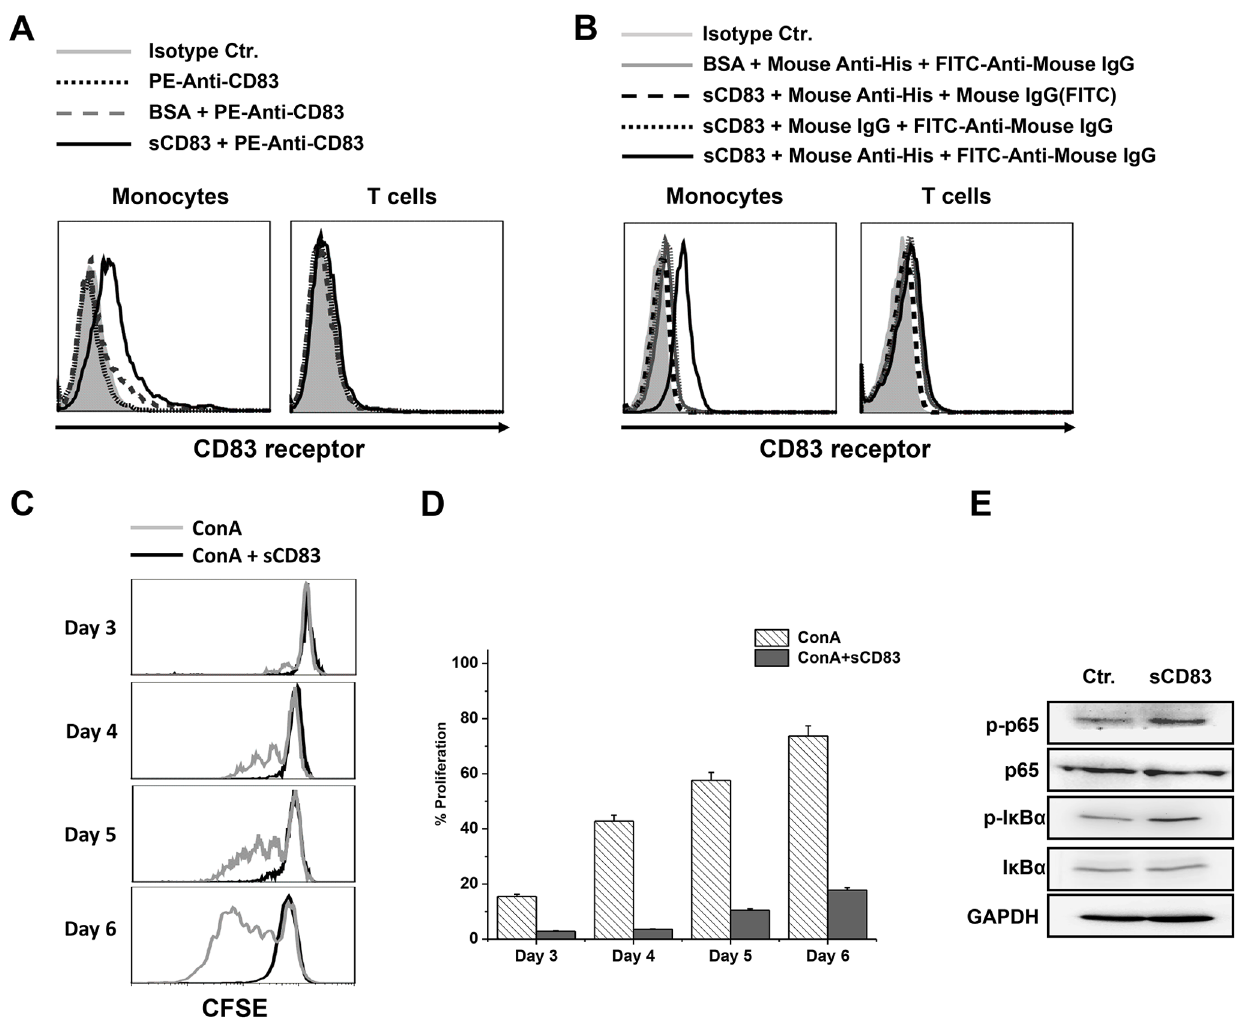
Figure 6. Biological activity determination of sCD83. sCD83 bound to the putative CD83 receptor on monocytes but not on T cells. (A and B) PBMC were incubated with soluble CD83 or BSA, and then coated with either PE-anti-CD83 (A) or anti-His followed by FITC-Anti-mouse IgG (B). Cells were then coated with anti-CD3 or anti-CD14 to distinguish the monocyte and T cells. CD14 + monocytes and CD3 + T cells were gated and analysis for CD83 receptor expression. (C) sCD83 suppressed ConA-stimulated PBMC proliferation. PBMCs were stained with CFSE, stimulated with ConA, and cultured with or without 20 m g/mL of sCD83 for the indicated time periods. (D) The means 6 the standard error of the mean (SEM) of the MFI from (C) are shown as bar graphs. (E) sCD83 activated the NF- k B pathway. Isolated human PBMCs stimulated by sCD83 (10 m g/mL) were cultured in RPMI 1640 medium that contained 10% fetal bovine sera at 37 u C for 12 h. The PBMCs were collected and lysed to detect the activation of the NF- k B pathway using Western